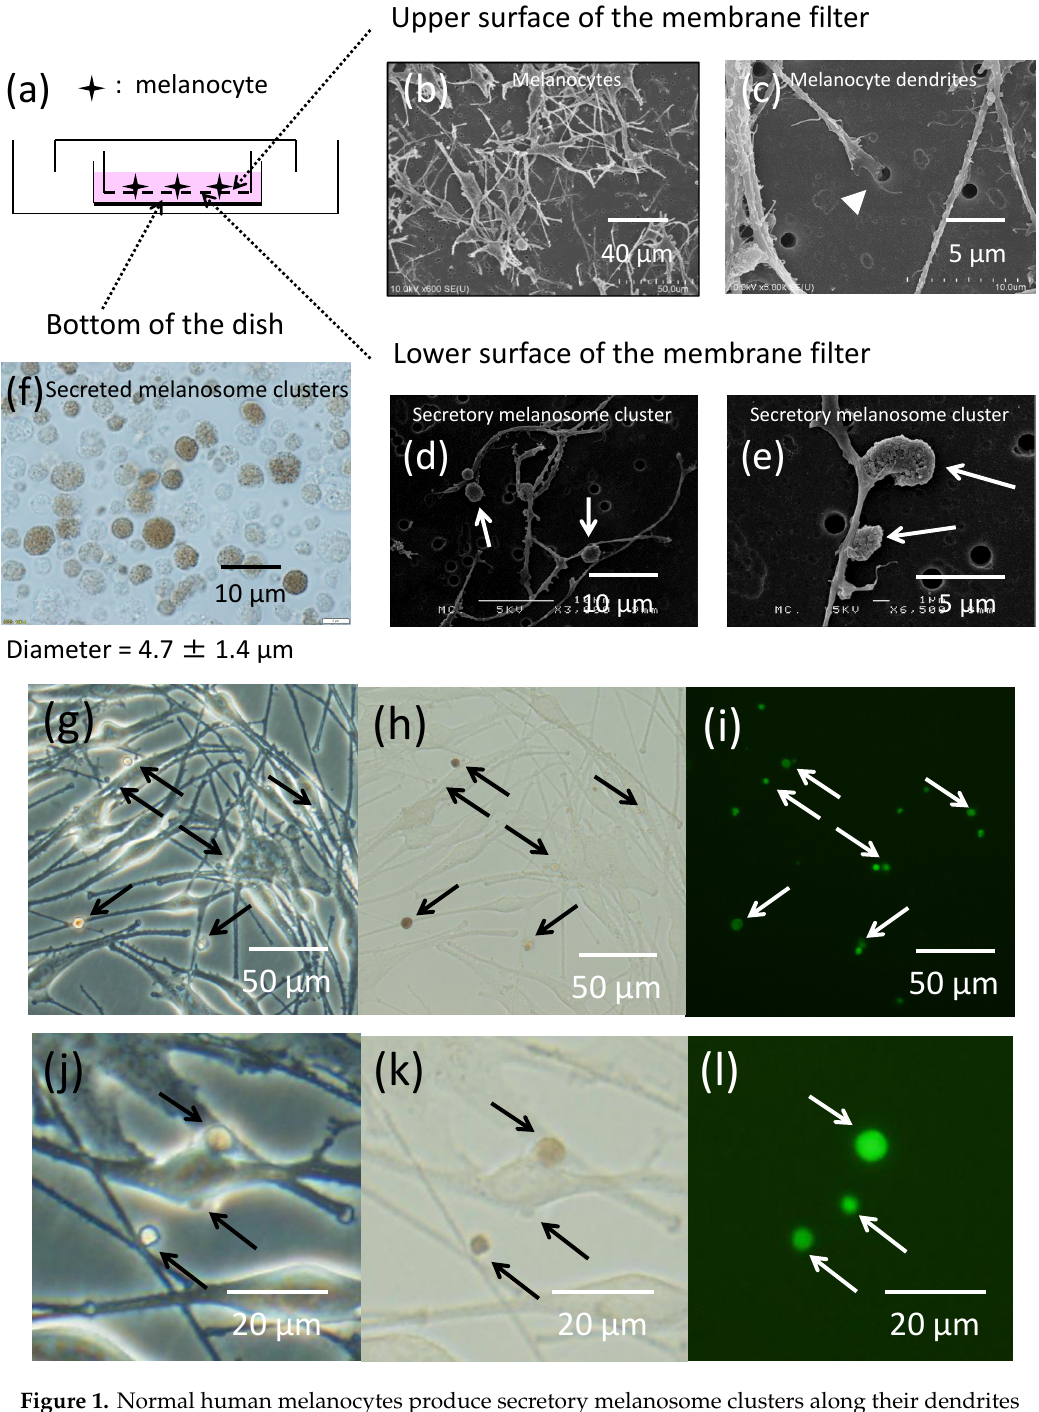
Figure 1. Normal human melanocytes produce secretory melanosome clusters along their dendrites with exposed PtdSer. ( a ) Normal human melanocytes were cultured for 6 days on microporous (1 µ m-pore) membrane filters. Scanning electron microscopic (SEM) images of ( b , c ) the upper surface and ( d , e ) the lower surface of a membrane filter are shown. The arrow-head indicates a melanocyte dendrite inserted into a pore and the arrows indicate secretory melanosome clusters. Light microscopic bright field image of secreted melanosome clusters that had dropped down to the bottom of the culture dish released from melanocyte dendrites that had penetrated through ( f ) the microporous membrane filter. The same field of melanocytes ( g – i ) at lower magnification and ( j – l ) at higher magnification is shown with ( g , j ) phase contrast, ( h , k ) bright field and ( i , l ) immunofluorescence staining of PtdSer by Annexin V. Arrows indicate secretory melanosome